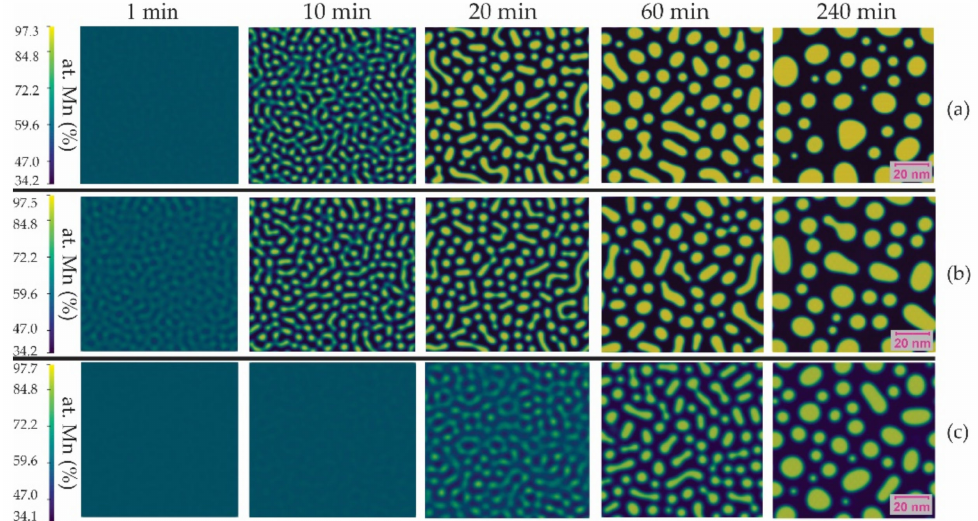
Figure 7. Microstructural evolution of Mn-30 at. %Cu alloy aged at ( a ) 300 ◦ C, ( b ) 400 ◦ C, and ( c ) 500 ◦ C for different